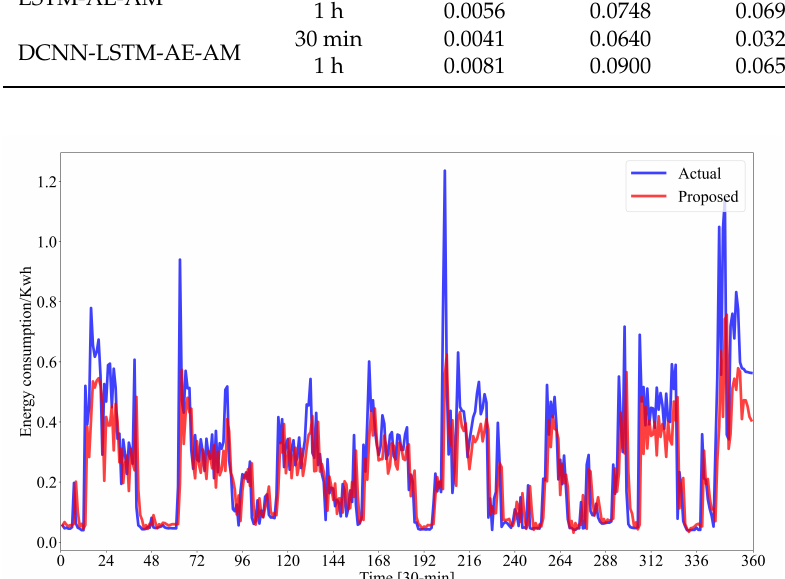
Figure 13. Prediction results of DCNN-LSTM-AE-AM on the SGSC dataset at a 30-min